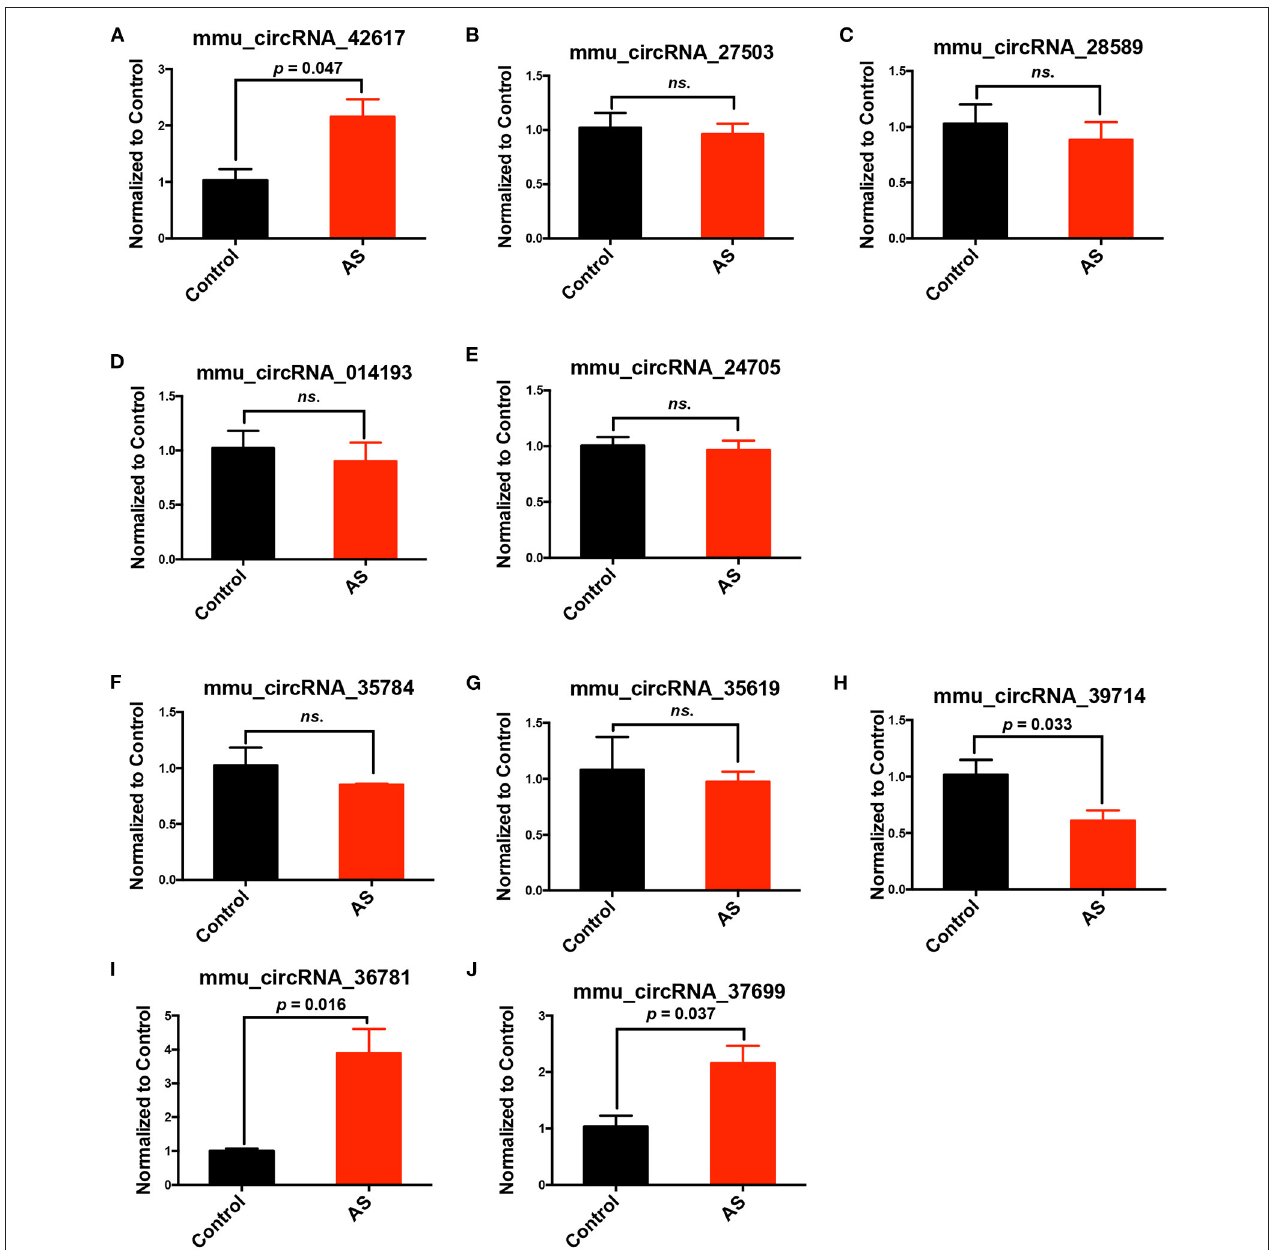
FIGURE 3 | Validation of differentially expressed circRNAs in AS vessels. (A–E) Expression of mmu_circRNA_42617, mmu_circRNA_27503, mmu_circRNA_28589, mmu_circRNA_014193, mmu_circRNA_24705 in aortic arches of control and AS mice; (F–J) mmu_circRNA_35784, mmu_circRNA_35619, mmu_circRNA_39714, mmu_circRNA_36781,mmu_circRNA_37699 in aortic arches of control and AS mice; n = 3. ns, no significant